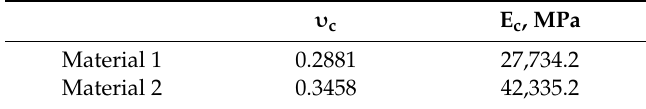
Table 2. Elastic constants determined during the virtual tensile